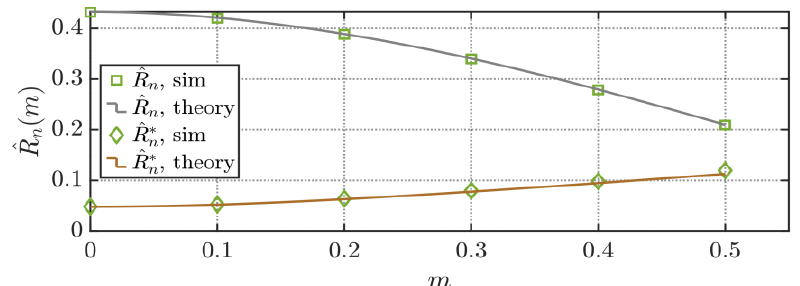
Figure 11. Three-phase split-capacitor converter normalized RMS numerical data points (green squares/diamonds, “ sim ”) and analytical profiles (solid lines) of the neutral current ripple as a function of the modulation index m x in case of single and three interleaved (“*”) carriers.